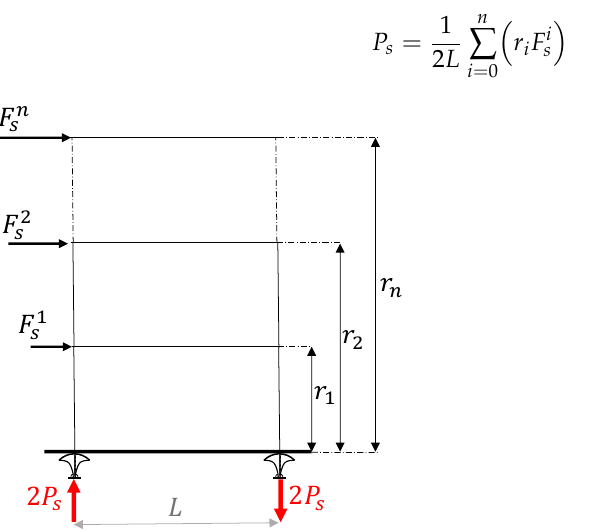
Figure 18. Scheme of tension/compression reactions on isolators due to seismic forces ( 𝐹 𝑠 ).